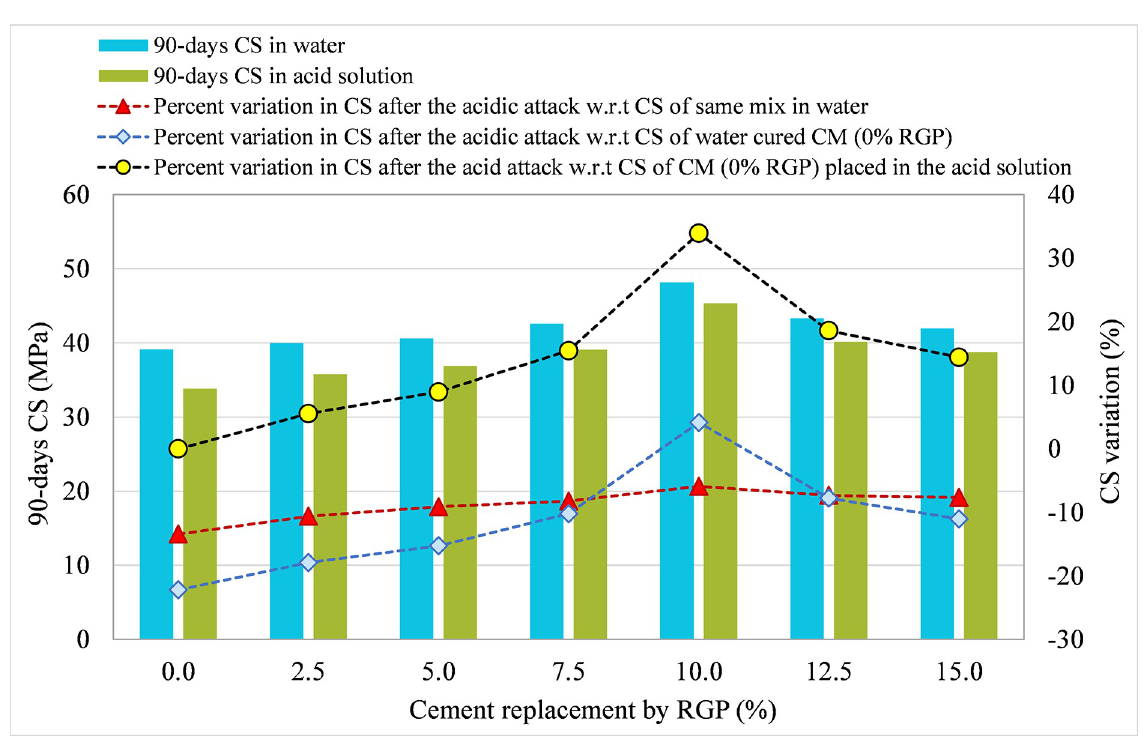
Fig 11. CS variation in samples placed in plain water and the acid solution for SF-20 mix incorporating RGP as a cement replacement.